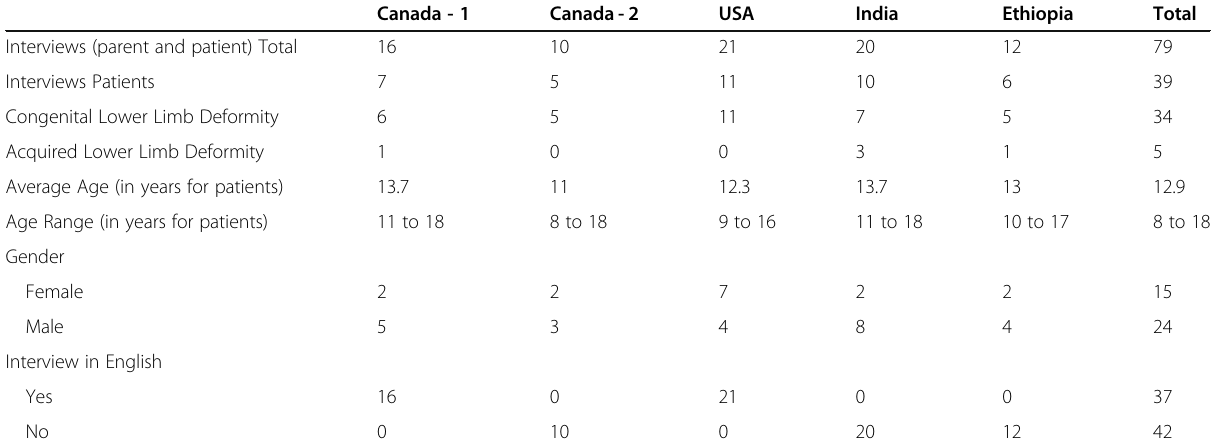
Table 1 Participant